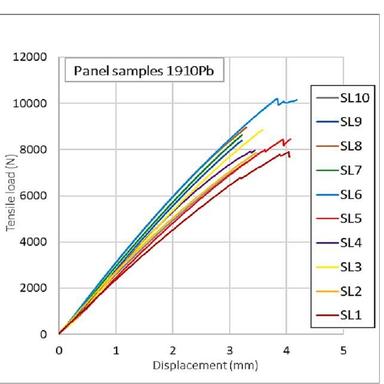
Representative example of the behavior curves of corrugated panels and measurements of their properties, as well as the behavior curves of ten 1910Pb panel samples under longitudinal tensile loading.